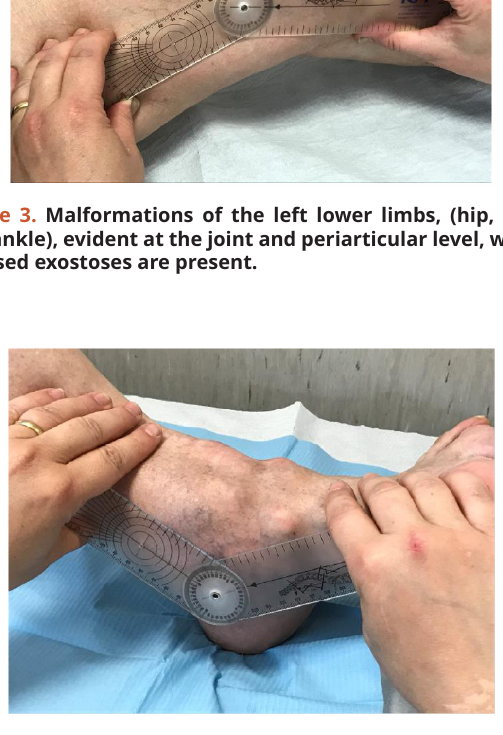
Figure 4. Complete ankylosis of the plantar flexion of 32 degrees.